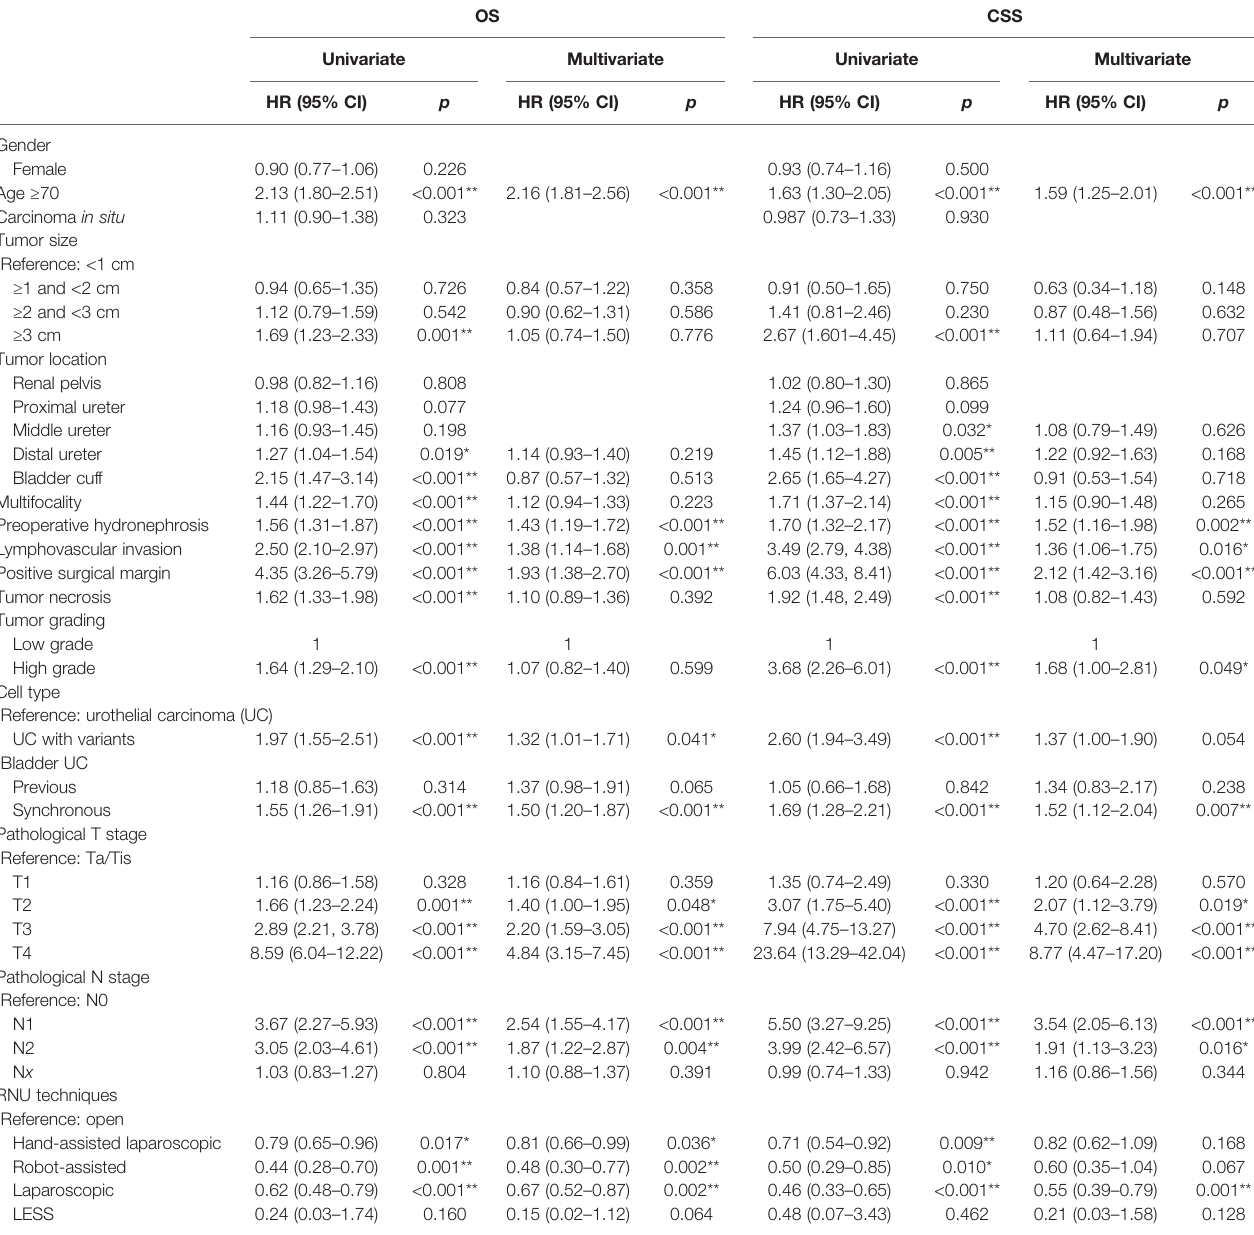
TABLE 2 | Comparative univariate and multivariate Cox regression analyses of overall survival (OS) and cancer-speci fi c survival (CSS) in patients with